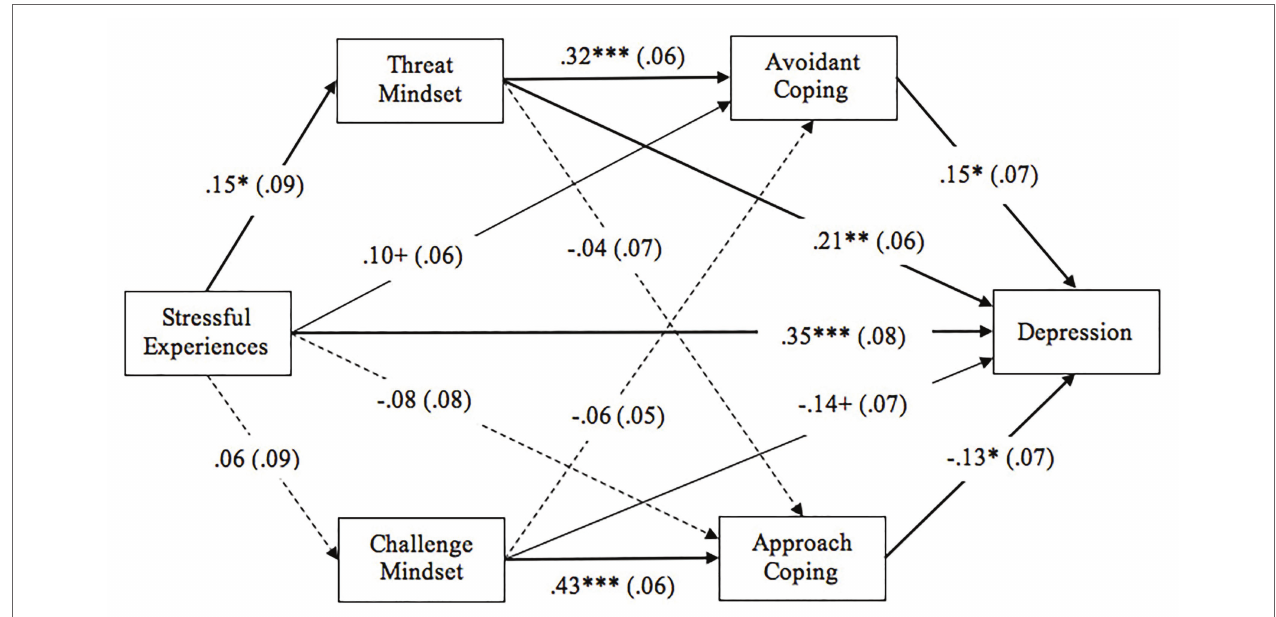
FIGURE 1 | The dual-pathway model of stress coping. Standard errors (SEs) are displayed in the parentheses. Bold lines indicate statistically significant relationship at p < 0.05. Normal lines indicate marginal relationship at p < 0.10. Dashed lines indicate nonsignificant paths. *** p < 0.001; ** p < 0.01; * p < 0.05; + p <